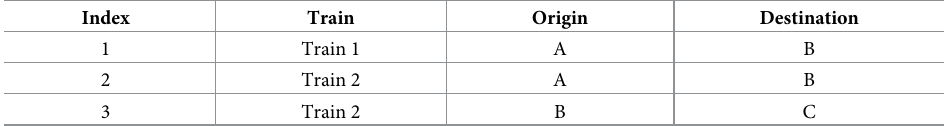
Table 2. List of resources in the example network.